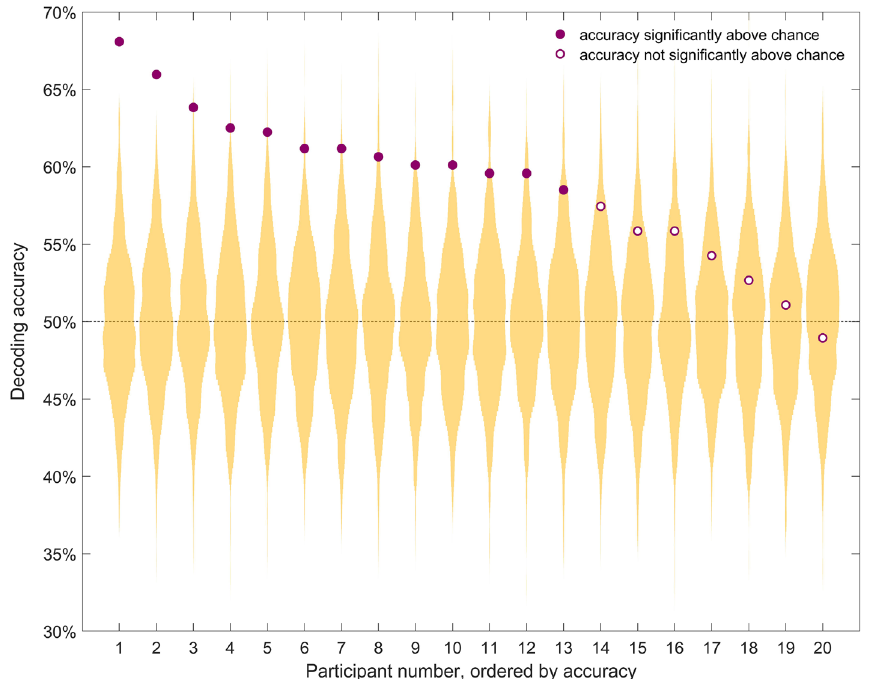
Figure 2. Individual decoding accuracy for classification of identical target words in congruent and incongruent contexts. Purple circles indicate decoding accuracy for each participant. The yellow distribution shows the null distribution obtained by the permutation test for that participant. Thirteen out of 20 participants had a decoding accuracy significantly above chance (full purple circles). Chance (50%) is indicated by the horizontal dashed line. Participants are sorted by decoding